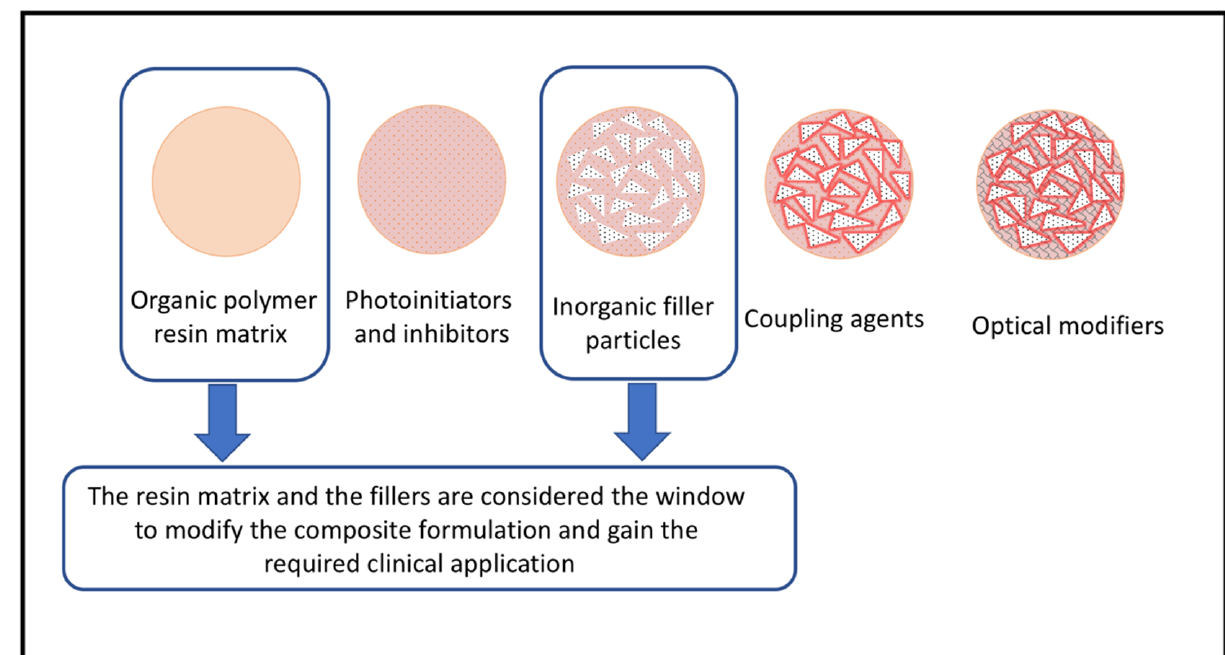
Figure 1. The illustration shows the main components of composite resin restorations.